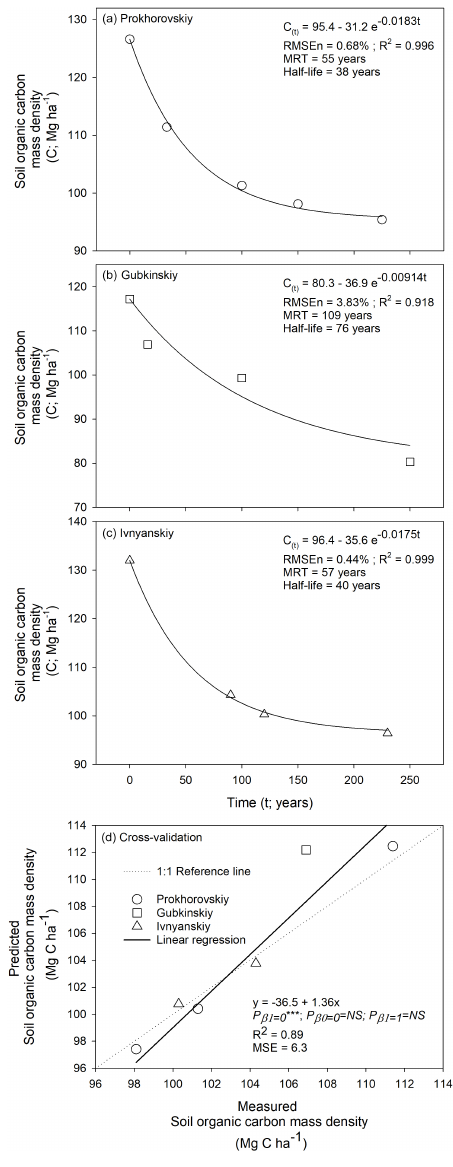
Figure 2. Land use chronosequences of soil organic carbon stor- age within the 0 to 30cm depth increment after converting native grassland to annual croplands in Belgorod Oblast, Russia. These results showed soil C declines over time. (a) Prokhorovskiy, (b) Gubkinskiy, and (c) Ivnyanskiy districts. In Panels (a) , (b) , and (c) , first-order kinetic models are described by the solid curvilinear fit- tings and equations in the form C ( t ) = C e + (C o − C e ) e − kt , where C e is C at new dynamic equilibrium (inputs = outputs), C o is ini- tial C at the time of land use conversion (time zero), and k is the first-order kinetic rate constant equivalent to turnover rate. As re- ciprocal of k , MRT stands for mean residence time, while half-life equates to ln(2) /k . (d) Cross-validation of first-order predicted C versus measured C encompassing the three chronosequences within the age range from 10 to 200 years. The subscripts of the P val- ues denote the null hypotheses for testing the regression coefficient ( β 1 ) and intercept ( β 0 ), where ∗∗∗ is a p value of < 0 . 001, and NS is not significant. First-order kinetic modeling was supported by this performance